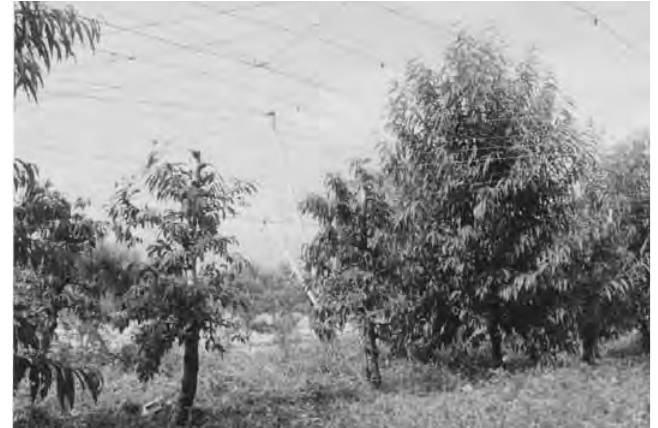
Fig. 1 - Peach trees just after summer pruning on 24 July (left: tree after summer pruning; right: tree without summer pruning)